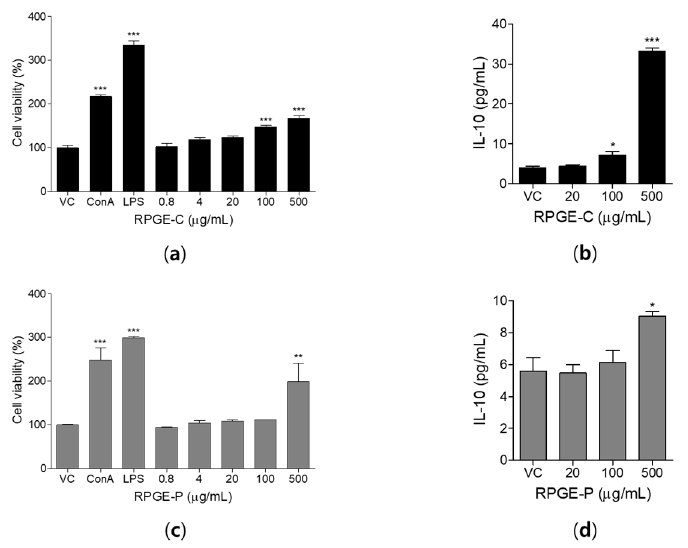
Figure 8. E ff ect of RPGE on cell viability and secretion of IL-10 in mouse splenocytes. ( a ) Mouse splenocytes were incubated with Con A (5 µ g / mL), LPS (1 µ g / mL), or various concentrations of RPGE-C; ( c ) Mouse splenocytes were incubated with Con A (5 µ g / mL), LPS (1 µ g / mL), or various concentrations of RPGE-P. Con A, Concanavalin A; LPS, lipopolysaccharide. The results were expressed as a relative value to that of VC, which is set to 100%. The data are represented as the mean ± SEM. ** p < 0.01 and *** p < 0.001 as when compared with the VC. ( b ) IL-10 protein level (RPGE-C); ( d ) IL-10 protein level (RPGE-P). All data are represented as the mean ± SEM. * p < 0.05 and *** p < 0.001 as when compared with the VC.